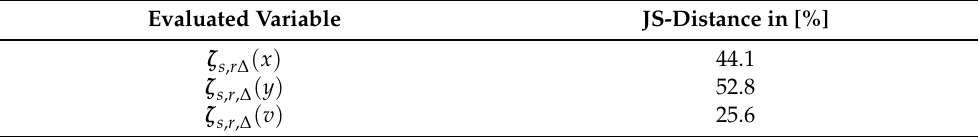
Table 4. The results for the far-range radar sensor, detection range 60 < x < 200 [m]. Evaluated